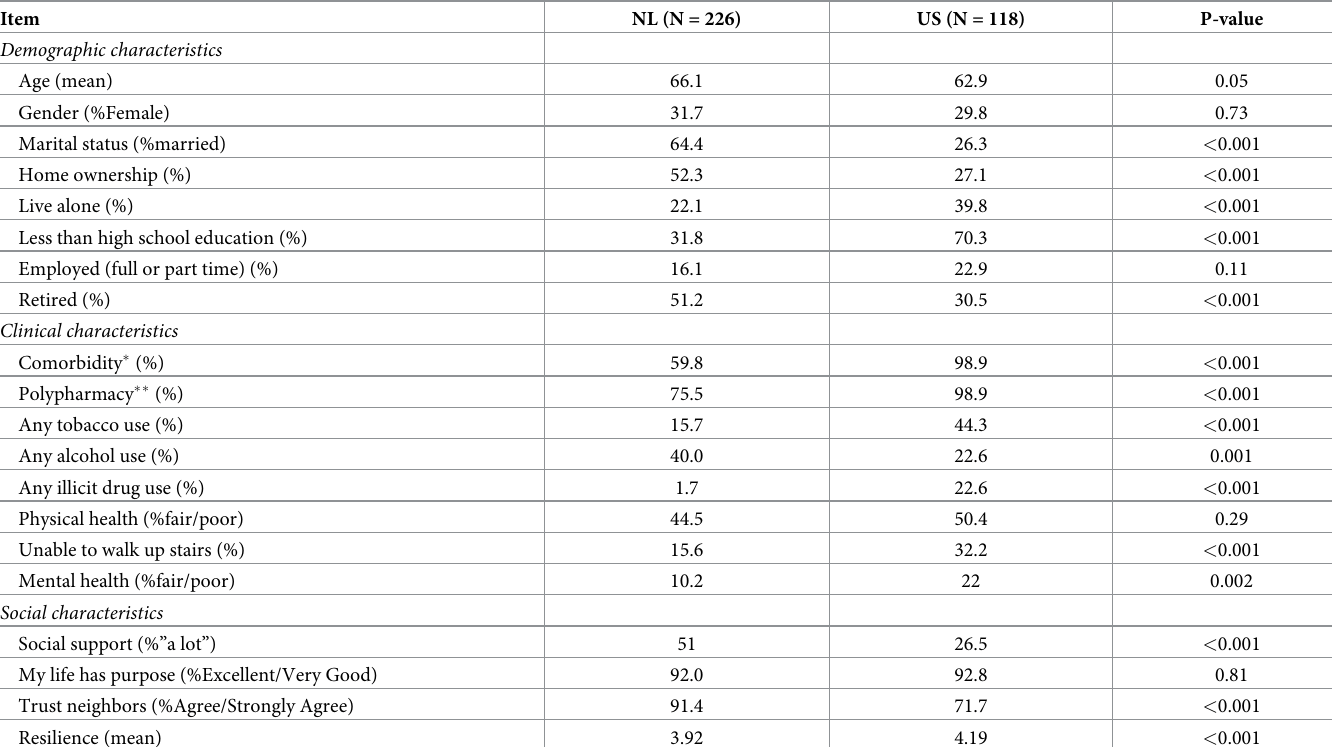
Table 2. US and NL participant demographic, clinical, and social